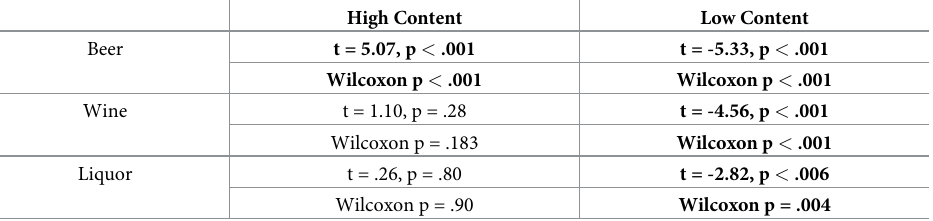
Table 4. Paired sample t-tests and Wilcoxon signed rank tests comparing ABV to standard drink errors for each type of drink. High Content Low Content Beer t = 5.07, p < .001 t = -5.33, p < .001 Wilcoxon p < .001 Wilcoxon p < .001 Wine t = 1.10, p = .28 t = -4.56, p < .001 Wilcoxon p = .183 Wilcoxon p < .001 Liquor t = .26, p = .80 t = -2.82, p < .006 Wilcoxon p = .90 Wilcoxon p = .004 All t-tests df. = 77. Bold values represent significant errors. Negative t-values represent underpours; positive t-values represent